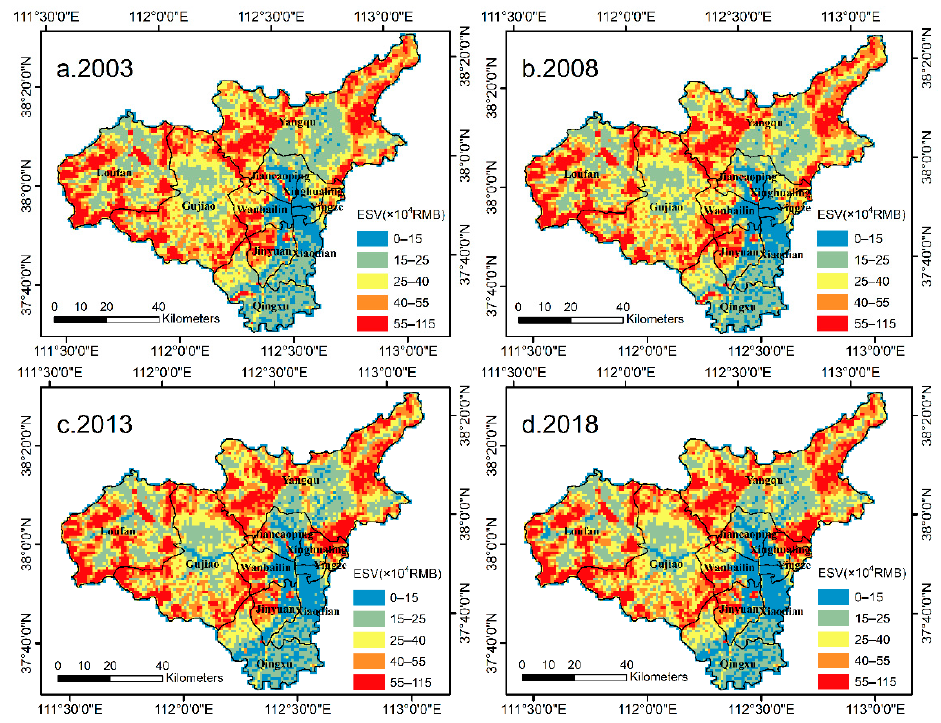
Figure 6. Spatial distribution of ESV of Taiyuan City from 2003 to 2018.